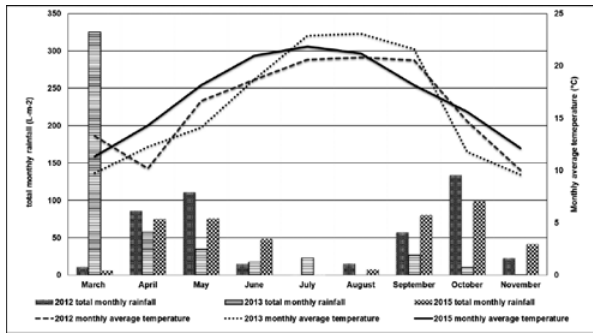
Figure 11. Mean monthly rainfall and temperatures for three trial years, 2012, 2013 and